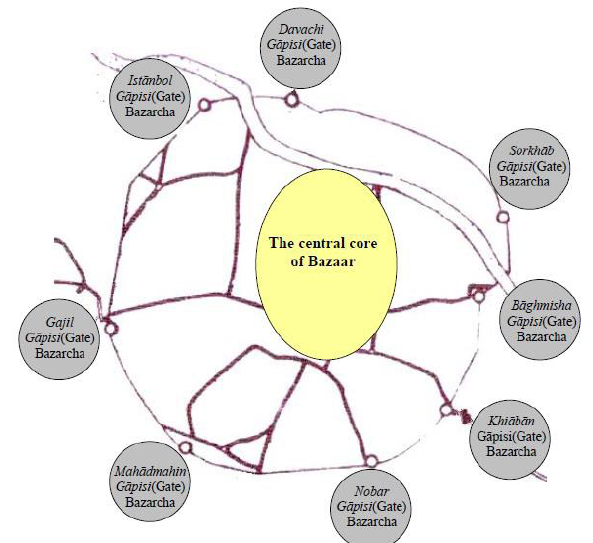
Figure 23. The Situation of Bazaar and Historical Gates of Tabriz Old City (UNESCO, 2009).